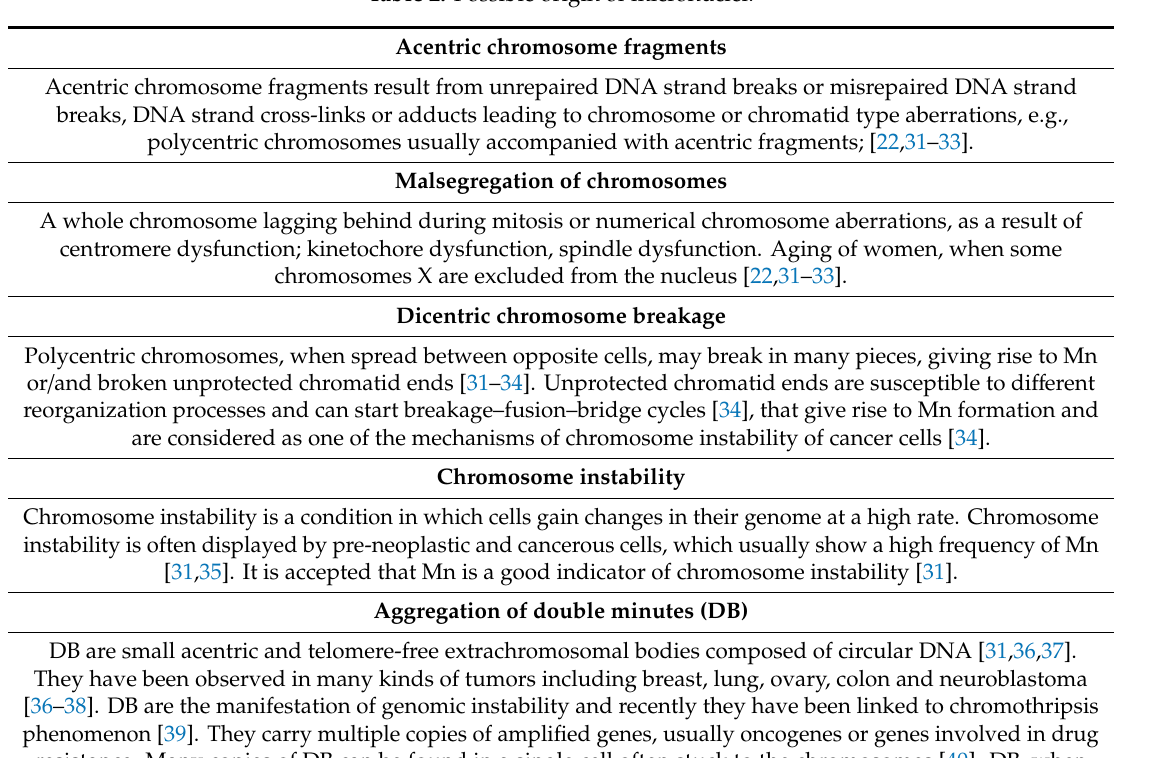
Table 2. Possible origin of micronuclei.